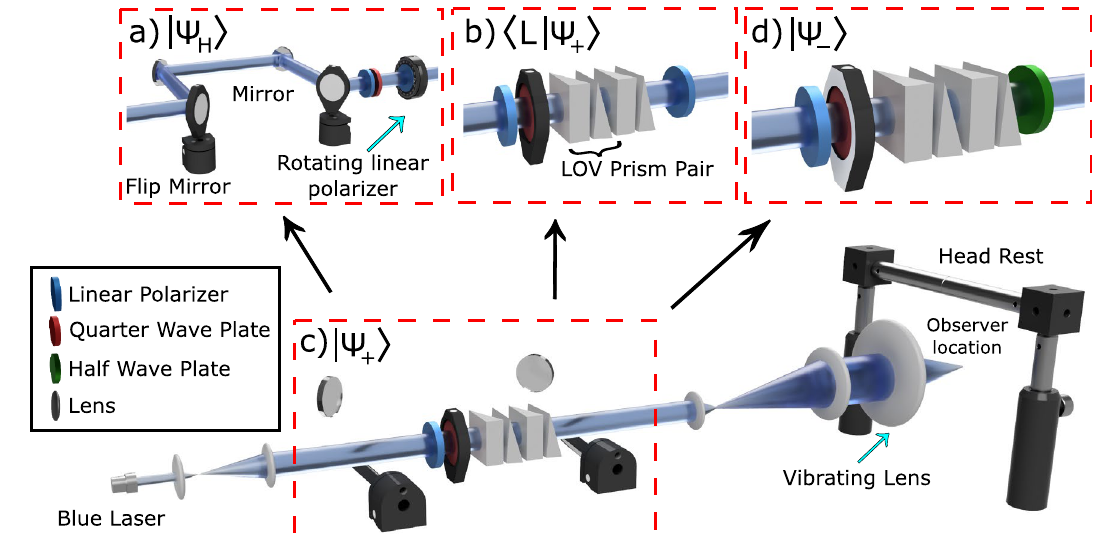
Figure 2. Schematic of the experimental setup with four different configurations for directing structured light onto the retina of the observer. ( a ) The first configuration prepares linearly polarized light with an orientation that rotates with a speed of approximately 1 Hz. This setup was used in the pre-study to determine if the participants were able to perceive Haidinger’s brushes when gazing at a fixed point. ( b ) The second configuration uses a polarization filter to prepare a doughnut shaped intensity profile. This configuration was used to familiarize the participant with the optimal eye movement during a familiarization period on the first day. The last two configurations, ( c , d ), prepare the two states of Eq. (2) which possess uniform intensity profiles and were used during the main